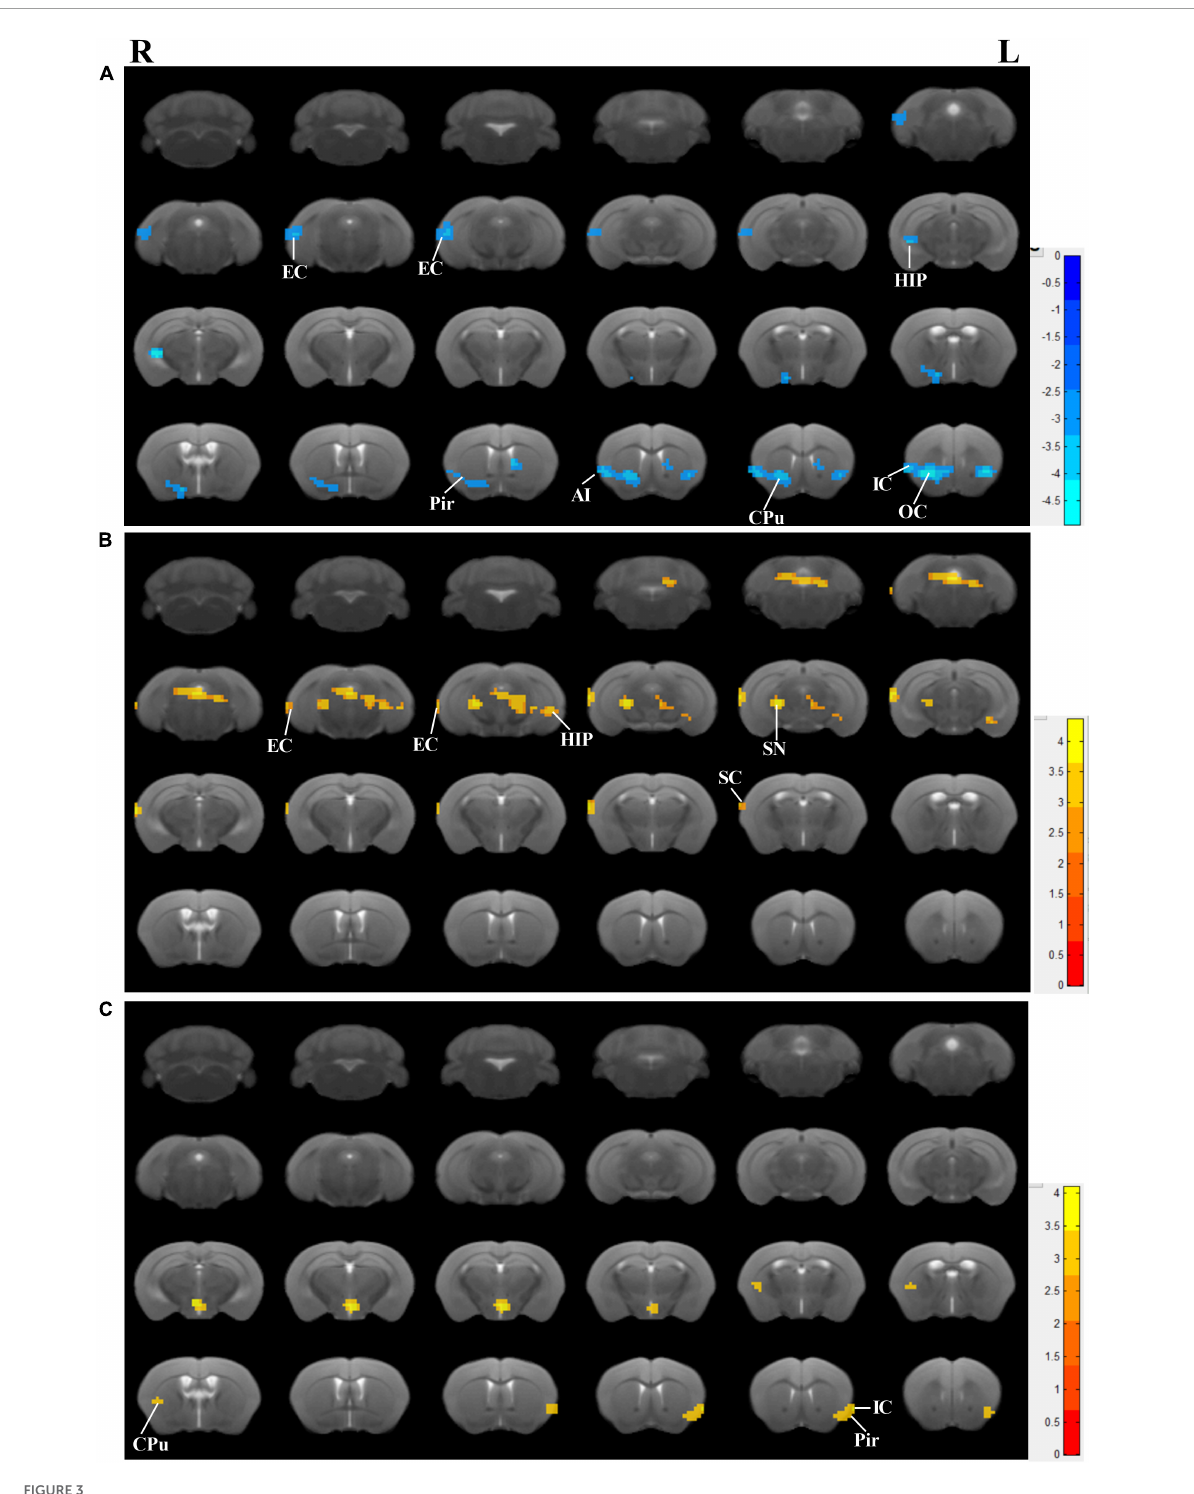
FIGURE3 Effects of the EA-treatment on regional spontaneous activity. (A) Regions manifesting significant ReHo value differences between 3 × Tg-AD mice and wildtype-control mice (blue, 3 × Tg-AD < wildtype-control; color bar represents significance of difference), (B) between EA-treated and untreated 3 × Tg-AD mice (red, untreated 3 × Tg-AD < EA-treated; color bar represents significance of difference), and (C) between Non-EA-treated and untreated 3 × Tg-AD mice (red, untreated 3 × Tg-AD < Non-EA-treated; color bar represents significance of difference). EC, entorhinal cortex; HIP, hippocampus; Pir, piriform cortex; CPu, caudate putamen; OC, orbital cortex; IC, insular cortex; SC, somatosensory cortex; SN, substantia